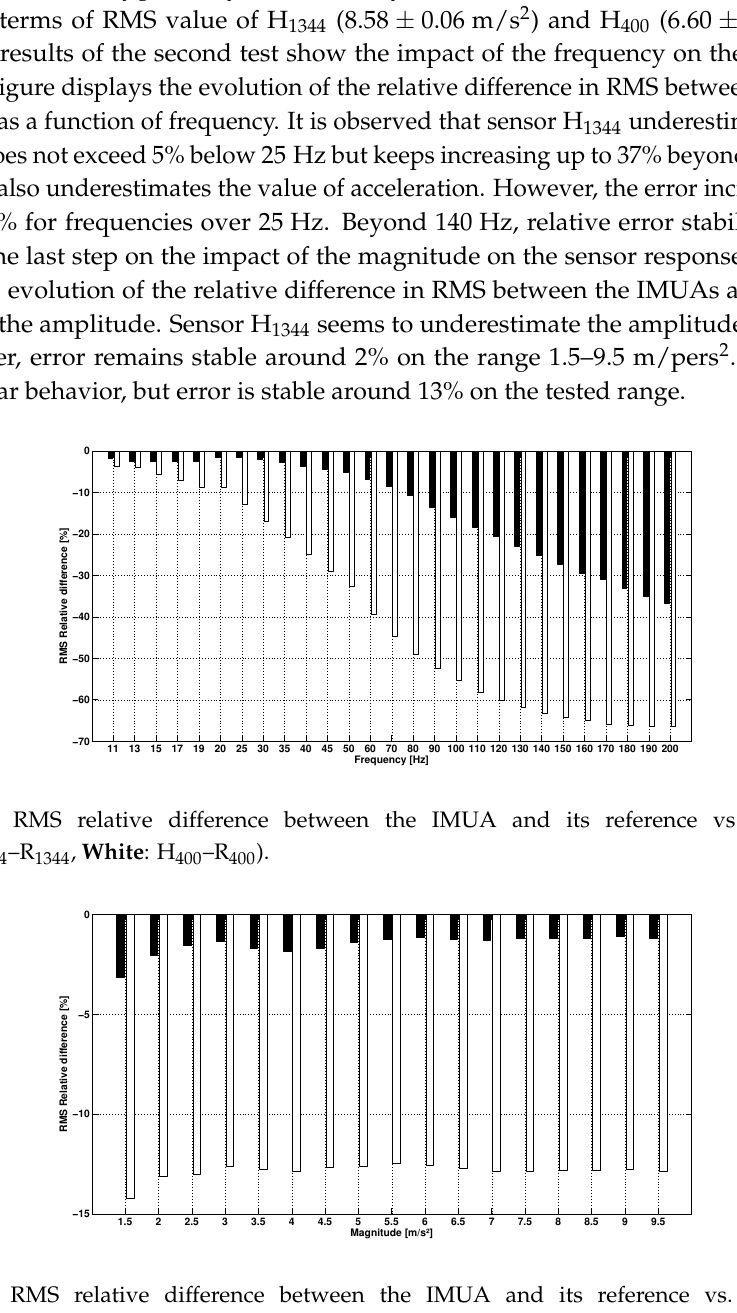
Figure 6. RMS relative difference between the IMUA and its reference vs. magnitude ( Black : H 1344 –R 1344 , White : H 400 –R 400